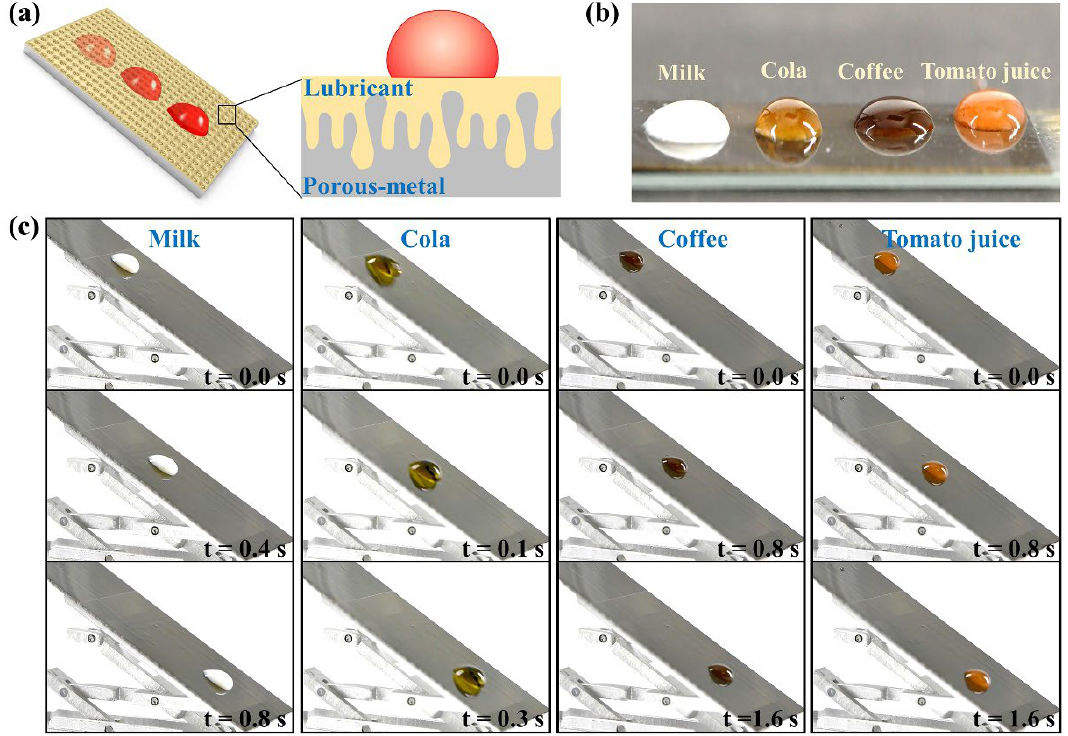
Figure 5. Anti-adhesion properties of lubricant-infused porous metal. ( a ) Anti-adhesion principle of lubricant-infused porous metal. ( b ) The static resistance of lubricant-infused porous metal to different liquids. ( c ) The dynamic resistance of lubricant-infused porous metal to different liquids.